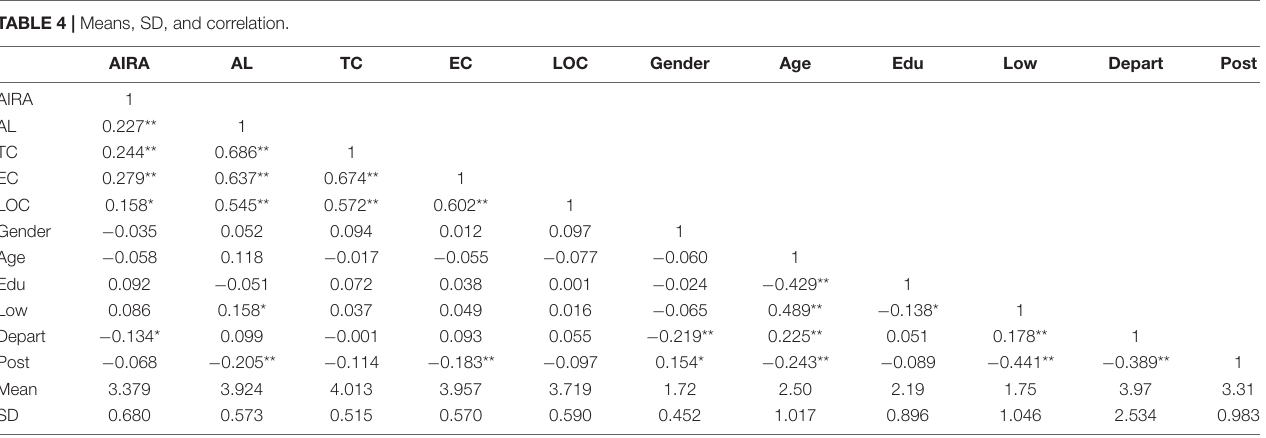
TABLE 4 | Means, SD, and correlation.